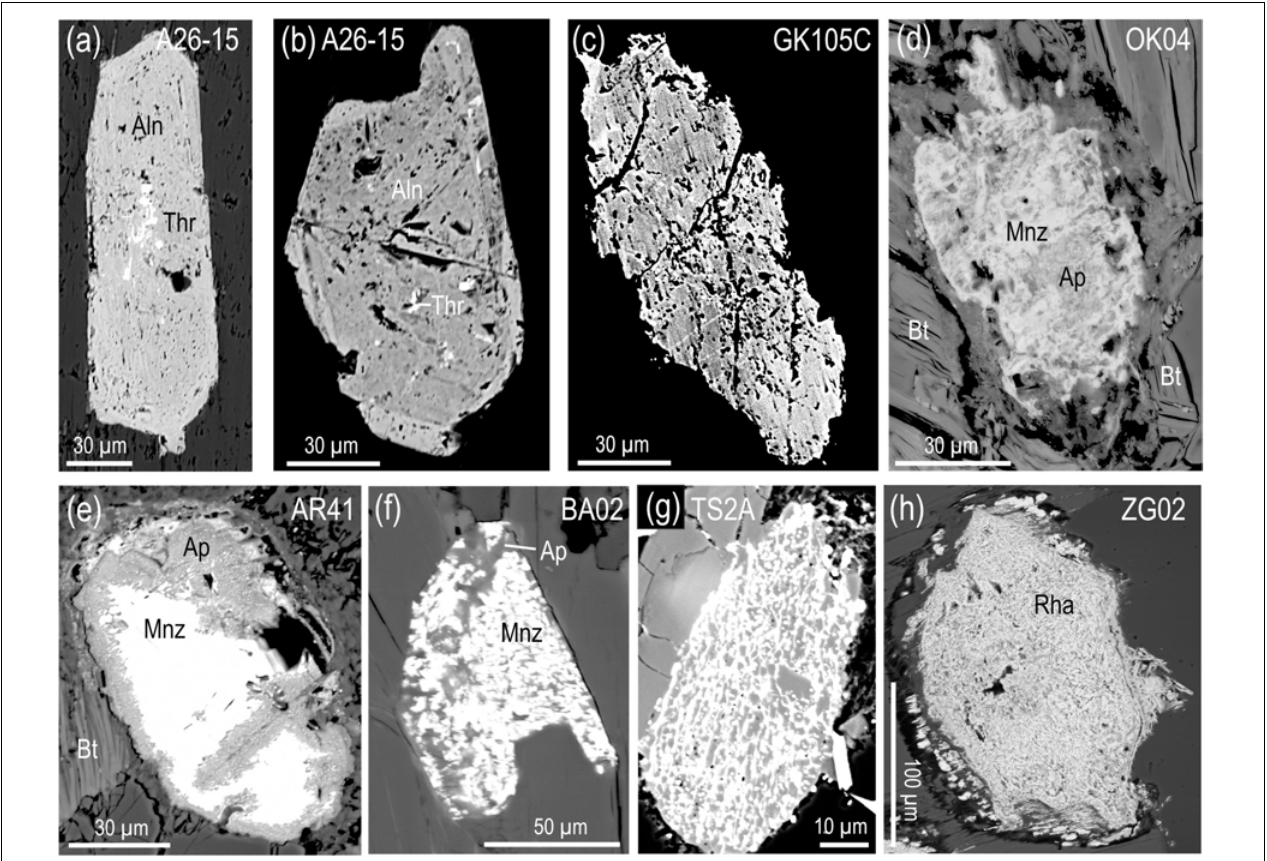
FIGURE 10 | Sponge-like microstructures of monazite decomposition and decay. (a,b) Allanite (Aln) pseudomorph of former monazite with numerous thorite (Thr), and anhedral monazite with numerous tiny holes and thorite inclusions in a zone of hydrothermal overprint, Bushmanland Terrane, Namaqua Province, RSA. (c) Internally corroded monazite with numerous elongated holes. (d) Relict monazite sponge microstructure with apatite (Ap) in micaschist from the Lower Unit in the Münchberg Nappe, Saxothuringian Zone. (e) Partial and graded decomposition of monazite to apatite in a micaschist from the Aiguilles Rouges Massif (Schulz and von Raumer, 2011). (f,g) Sponge-like intergrowth of monazite relicts and apatite pseudomorphing a large monazite grain. (h) Complete transformation of a large monazite grain to a pseudomorph of fibrolithic rhabdophane (Rha) in Zinnwald greisen granite.